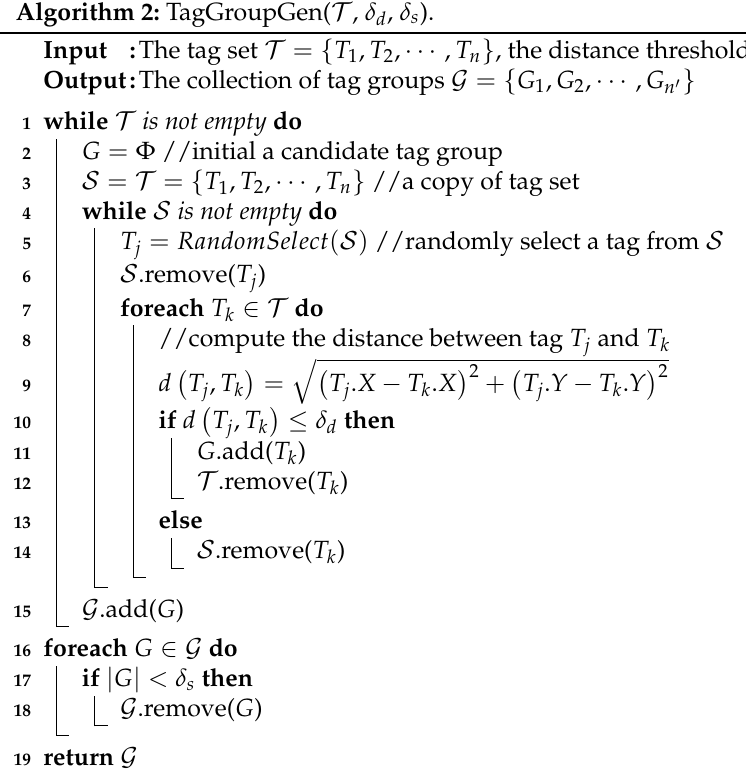
Algorithm 2: TagGroupGen( T , δ d , δ s